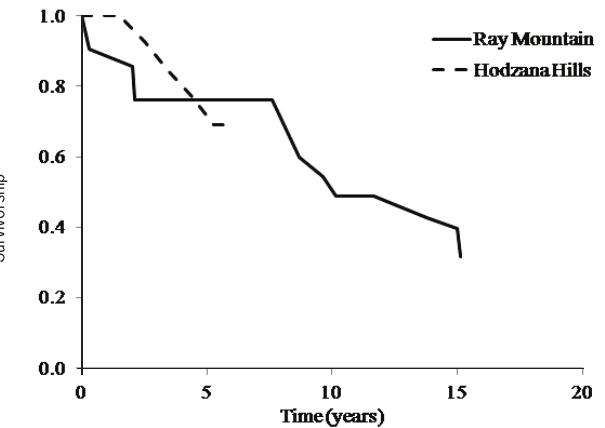
Figure 4. Staggered entry Kaplan-Meier survival functions for female caribou of the Ray Mountain (1994-2009) and Hodzana Hills (2003- 2009) herds in central Alaska.